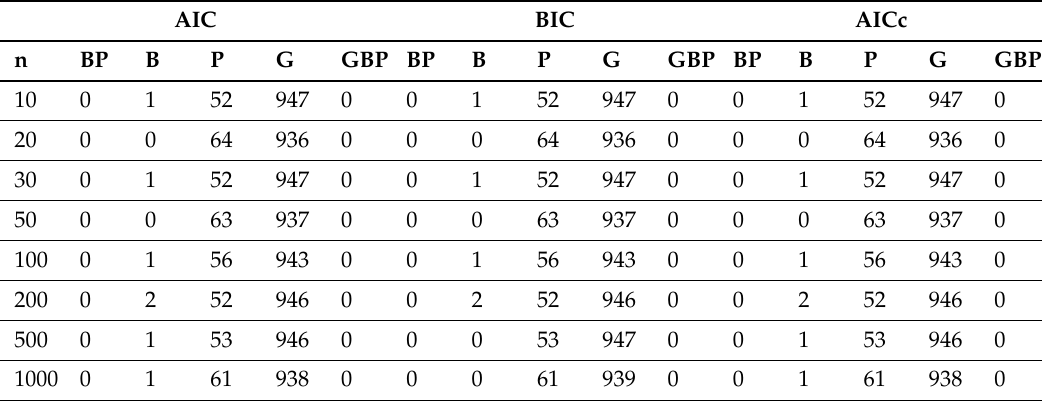
Table 16. Smaller AIC/BIC/AICc scores in 1000 simulations from a censored Gamma distribution G ( α , β ) with α = 2, β =